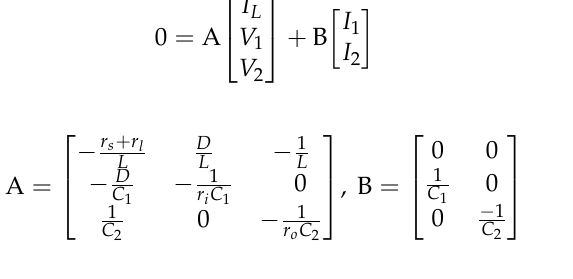
Figure 6. Circuit configuration of the proposed bi-directional DC–DC converter based DCSOP. The inductor parasitic resistance r l and the MOSFET turn-on resistance r s are included in the model. The transfer function for this converter has been derived based on and the input vector u = [ I